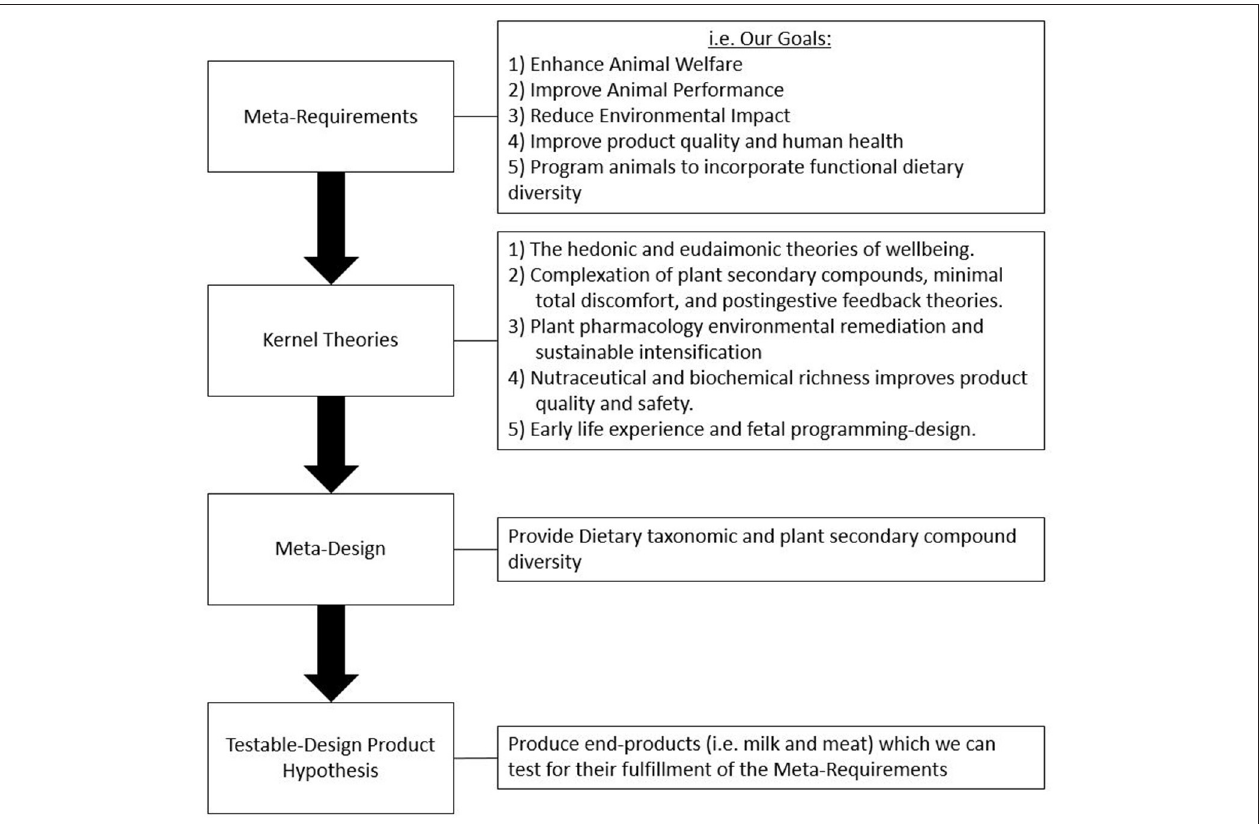
FIGURE 1 | The process of design theory for products and how this process can be applied to animal design through dietary diversity (Adapted from Walls et al., 1992 ).